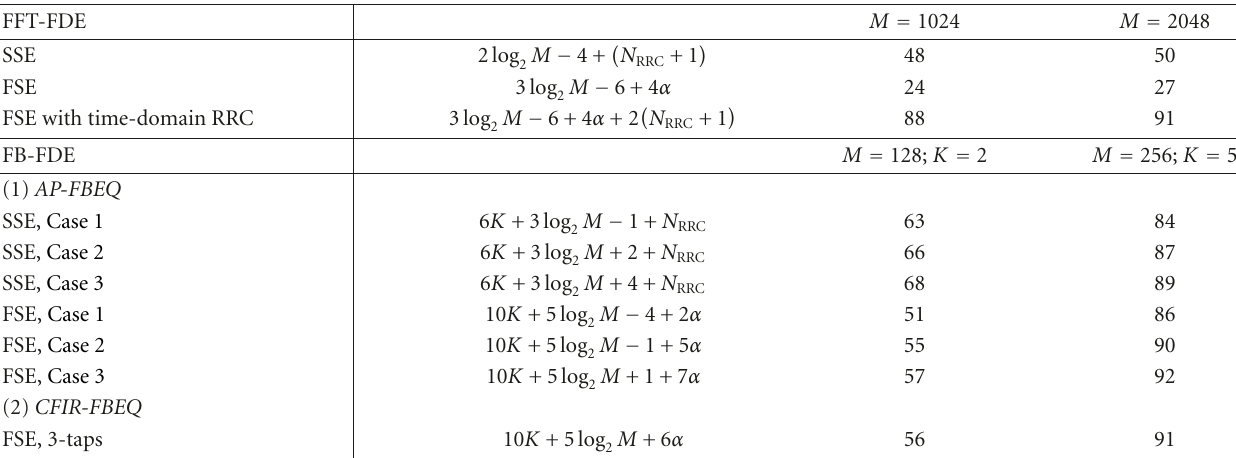
Table 2: Receiver complexity comparison between the FB-FDE and FFT-FDE receivers: number of real multiplications per symbol.